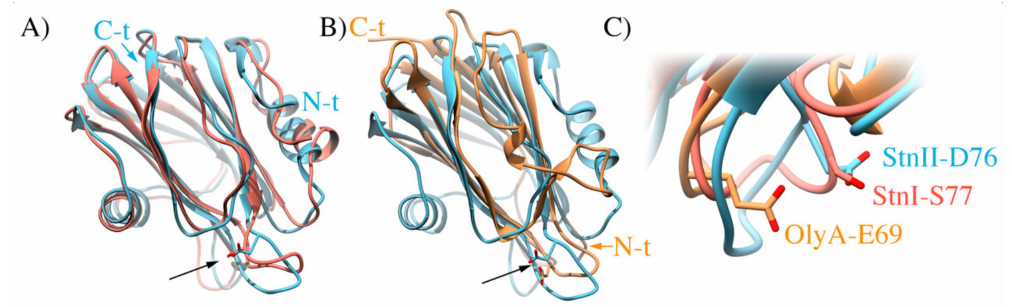
Figure 8. ( A ) Overlapping structures of StnI (salmon; PDB ID 2KS4) and StnII (cyan; PDB ID 1GWY). The arrow points at residues D76 of StnII and S77 of StnI. ( B ) Overlapping structures of StnII (cyan) and OlyA (orange; PDB ID 6MYI). The arrow points at residues D76 of StnII and E69 of OlyA. ( C ) Close up to the compared position, showing the sidechains of the mentioned residues as sticks. Colors as in ( A , B